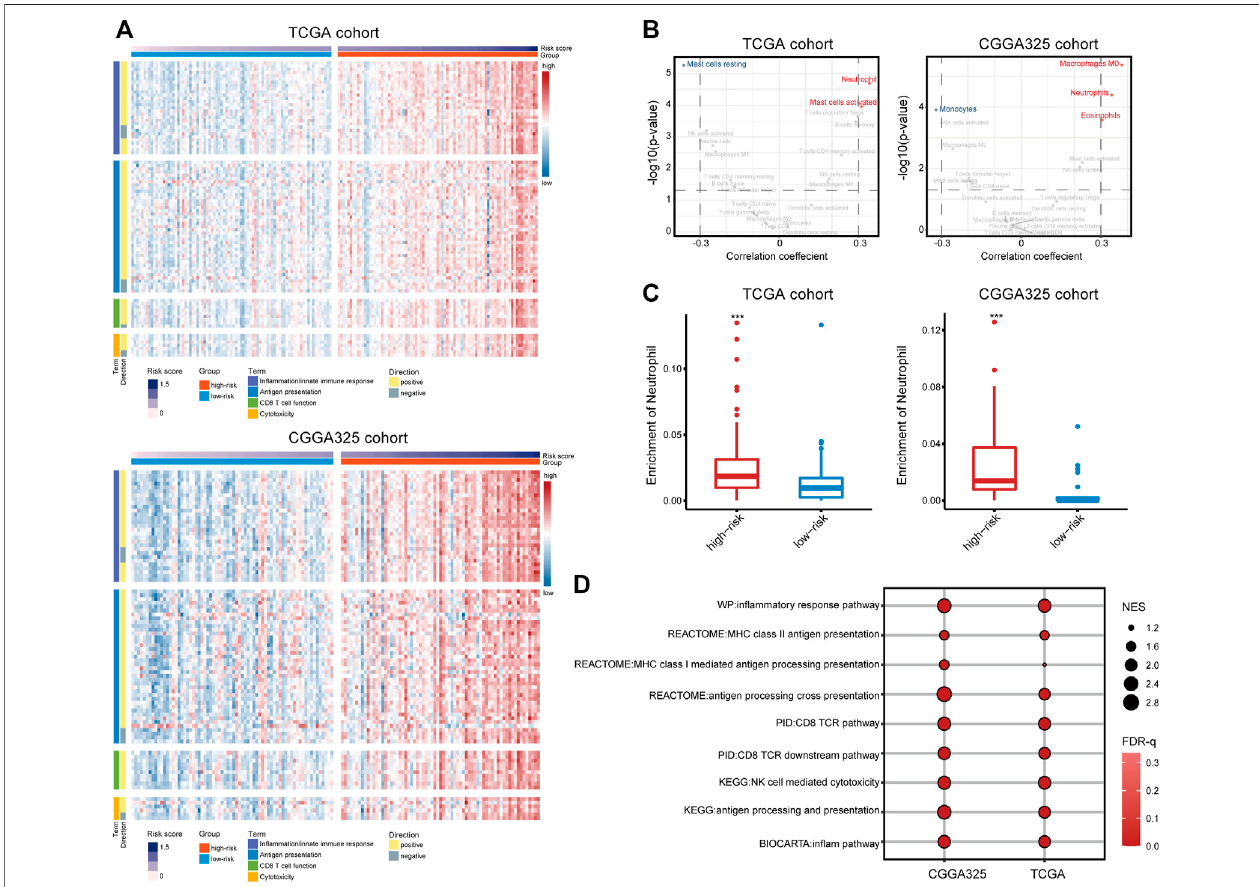
FIGURE 4 | (A) The ssGSEA scores of 103 signaling pathways involved in the in fl ammation/innate immune response, antigen presentation, CD8 T cell activation, and cytotoxicity. (B) Correlation analysis of the 22 immune cells estimated by CIBEROST with the risk score. (C) The fraction of neutrophils in the high- and low-risk groups. (D) GSEA analysis of pathways involved in the anti-tumor immune